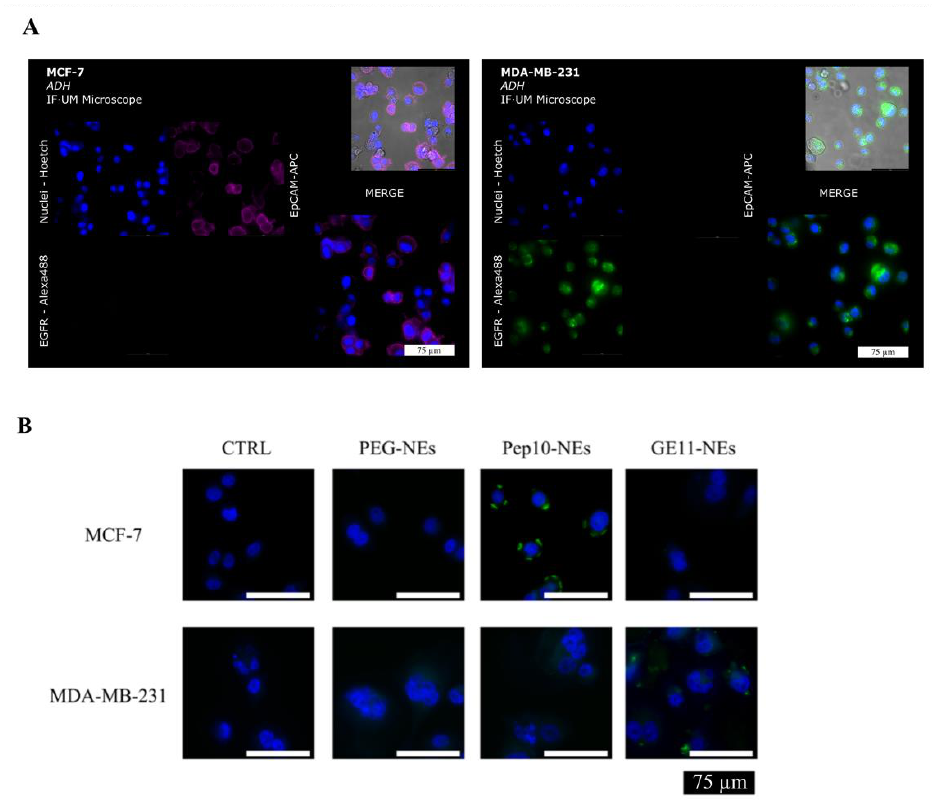
Figure 6. Specific binding analysis of Pept-NEs. ( A ) Specific expression of EpCAM by MCF-7 cells and EGFR by MDA-MB-231 cells. ( B ) Binding analysis by fluorescence microscopy of PEG-NEs and Pept-NEs to MDA-MB-231 and MCF-7. Negative controls (CTRL) show cells without PEG-NEs or Pept-NEs incubation. Scale bar represents 75 µm. Fluorescent images, blue arising from DAPI- Stained nuclei (cell nuclei) and green from fluorescent phosphatidylcholine introduced during the formulation of NEs.